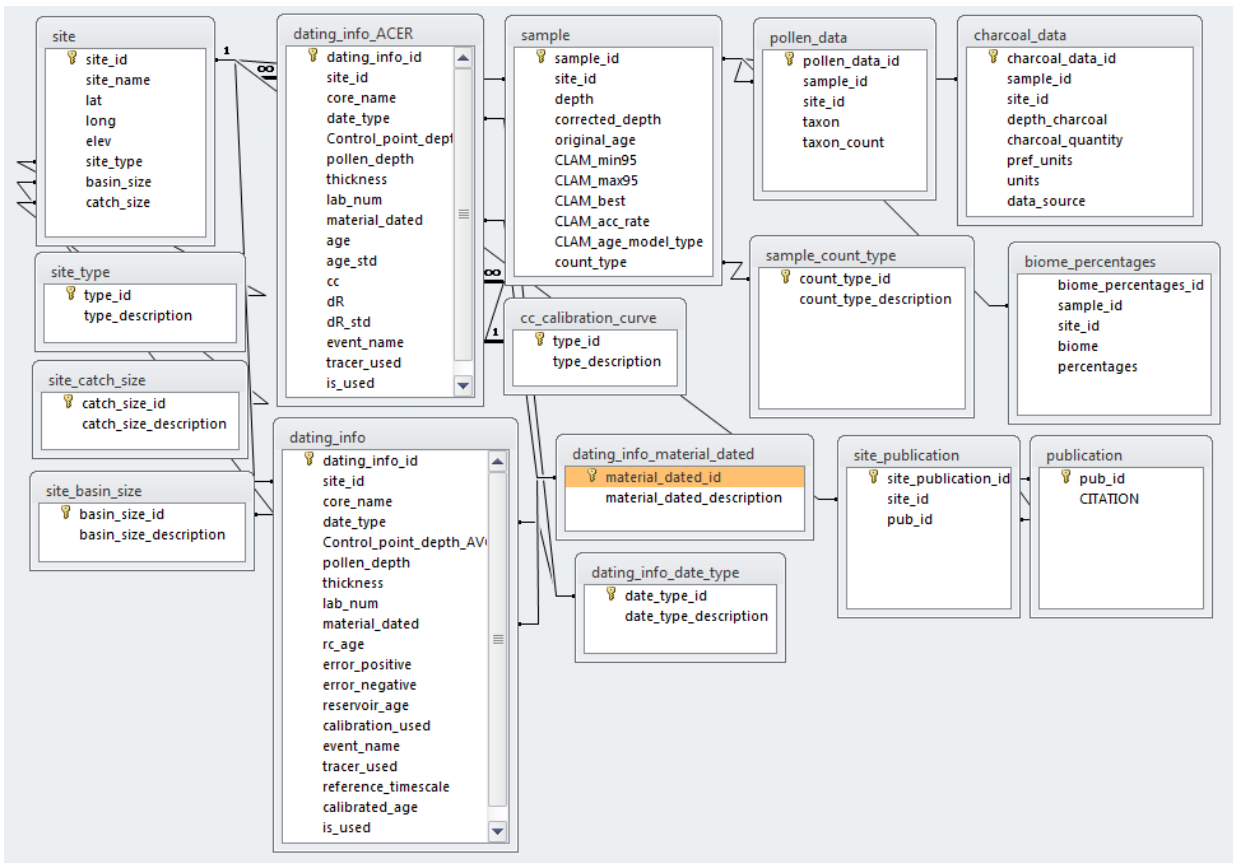
Figure 1. ACER database structure in ACCESS